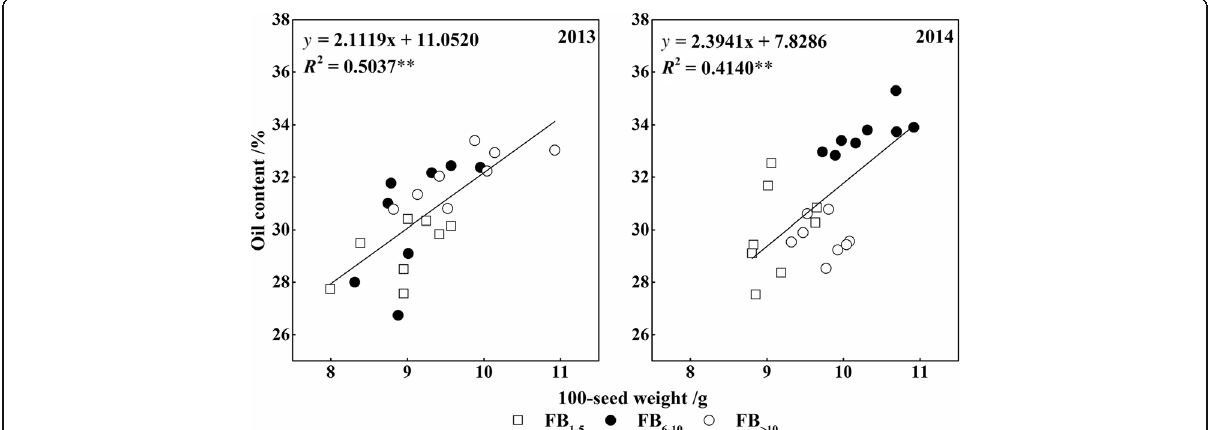
Fig. 2 Relationships between 100-seed weight and cottonseed oil content on different fruiting branches under plant density and MC treatment in Sikang 1 in 2013 and